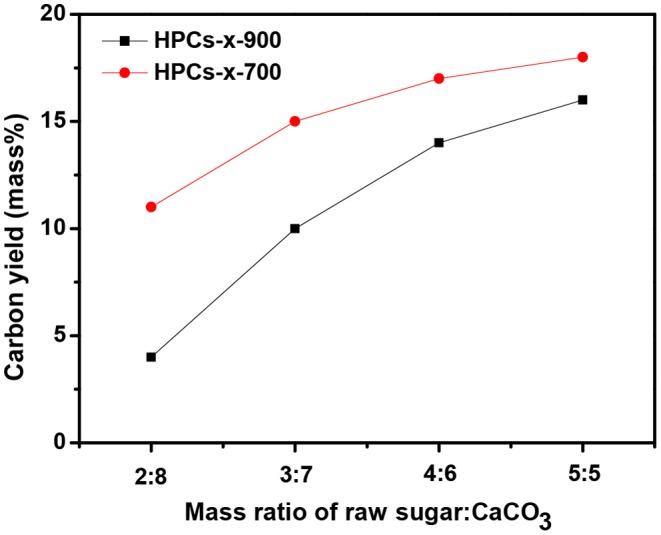
Carbon yield of HPCs-x-900 and HPCs-x-700 samples as a function of the mass ratio of raw sugar:CaCO3.